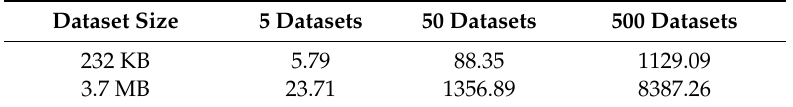
Table 1. Total extraction times, in seconds, when the platform contains multiple registered datasets.